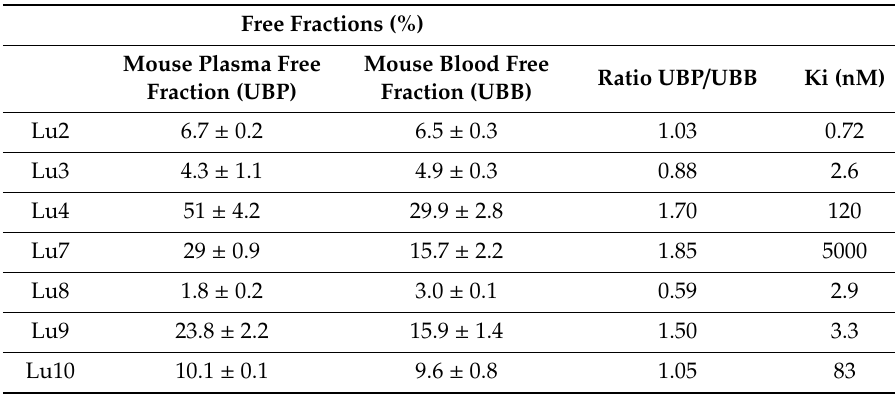
Table 4. Binding to plasma and blood proteins for HSP90 inhibitors.